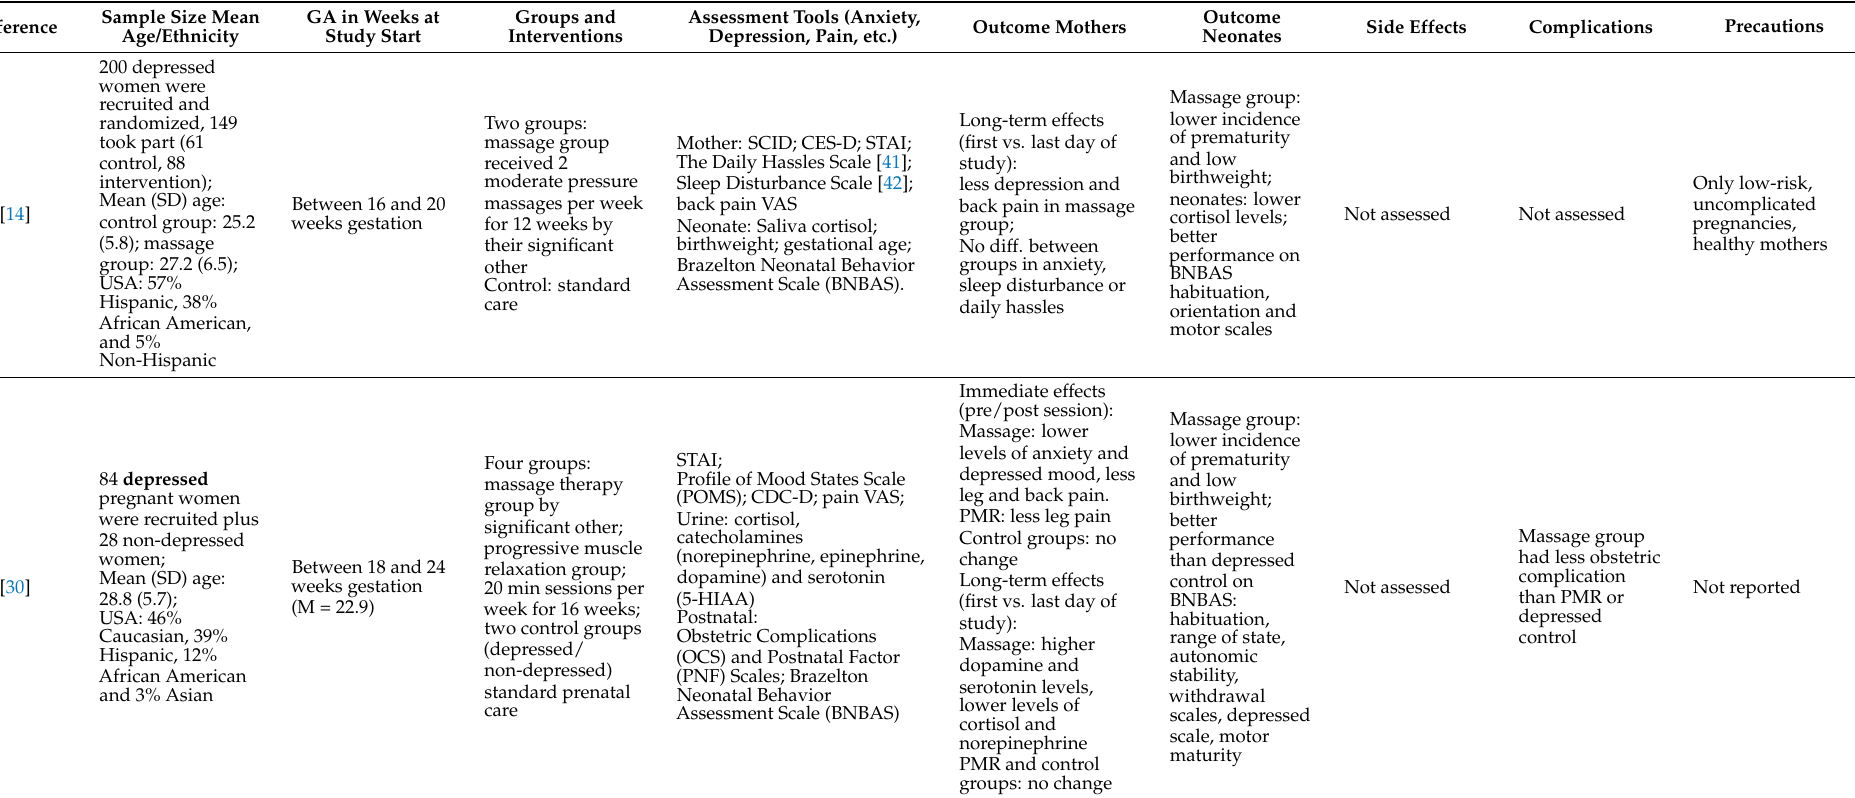
Table 2. Description of included